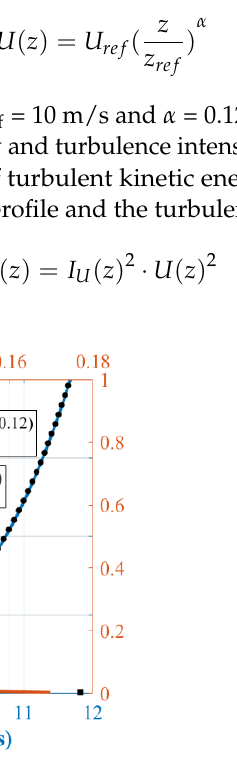
Figure 9. Drag coefficient values in current and previous studies. Figure 10. Force coefficient in CFD simulation and wind tunnel tests. 3.3. Stochastic Simulation Based on the wind tunnel tests, the wind force of the individual members was as- sumed to have the same wind load characteristic as that of the whole body (Xiao et al. [18]). In addition, the same mean root square of wind force was used. Katagiri [36] noted that the nondimensional auto-power spectrum of the wind load is independent of the height. Thus,